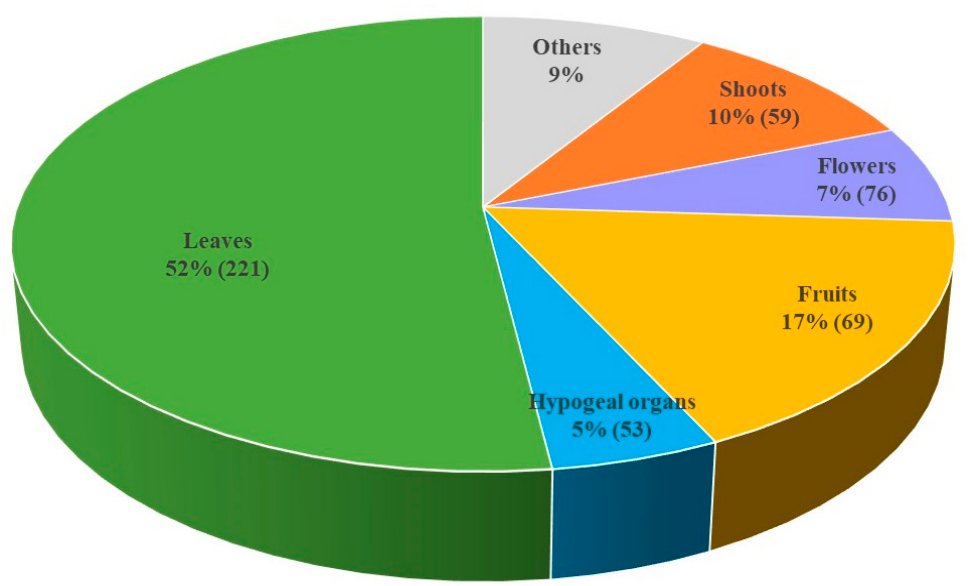
Figure 3. URs% and (number of species) for the most cited plant